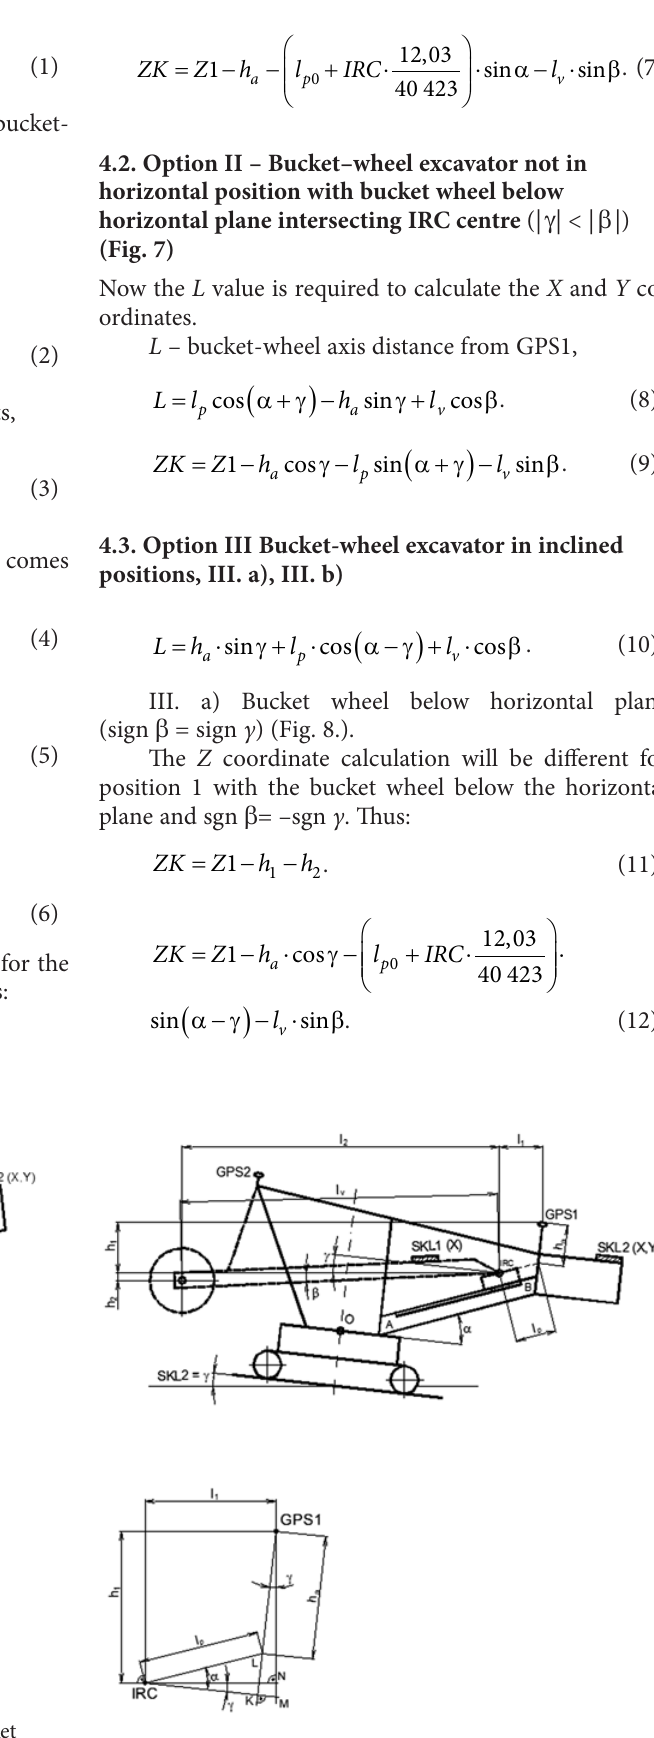
Fig. 8. Bucket wheel below horizontal plane sign β = sign